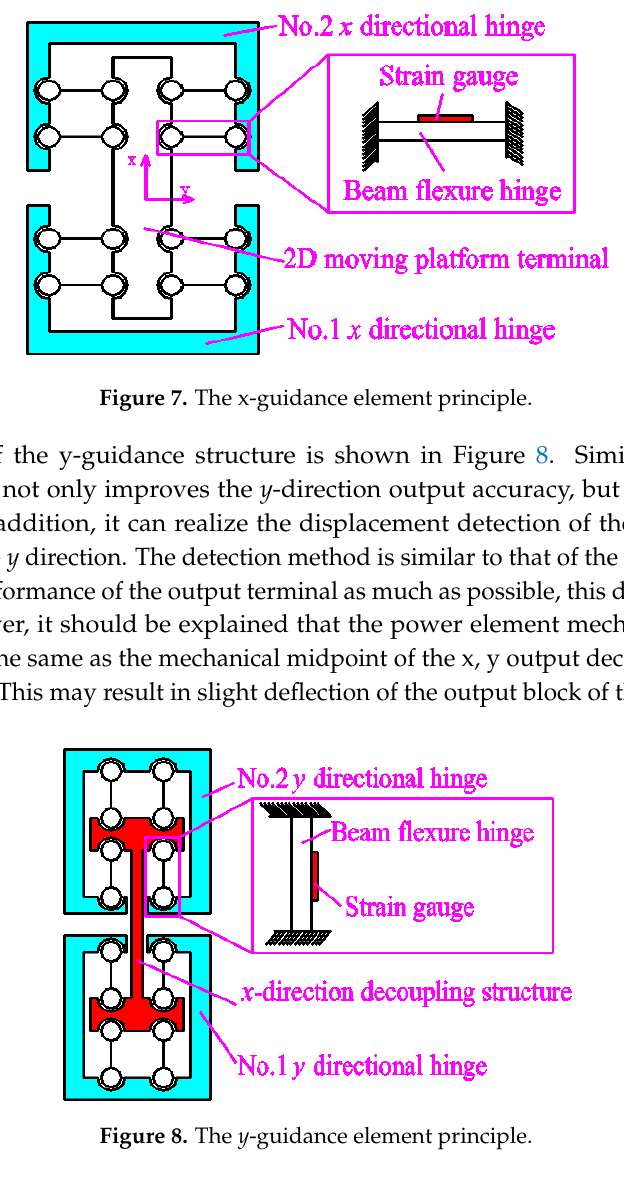
Figure 6. Common force conditions during work.